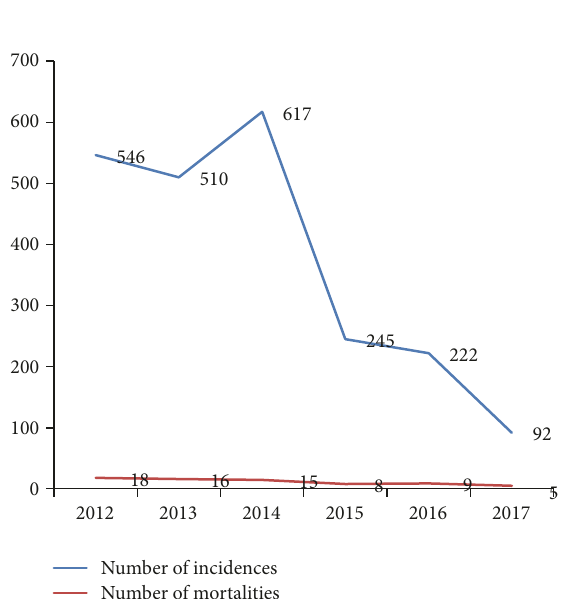
Figure 2: Trends of leishmaniasis in Kahsay Abera Hospital from 2012 to